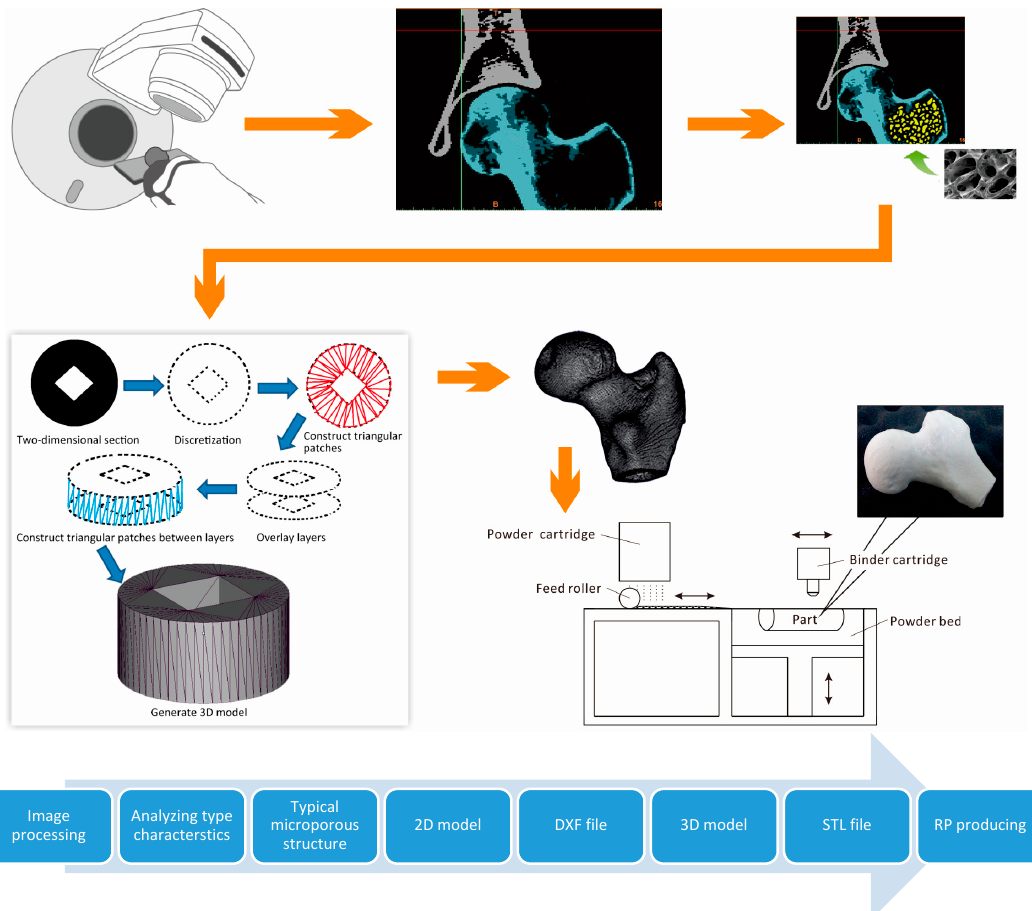
Figure 4. Bionic design and manufacturing process of the inner microstructure of artificial bone scaffold.